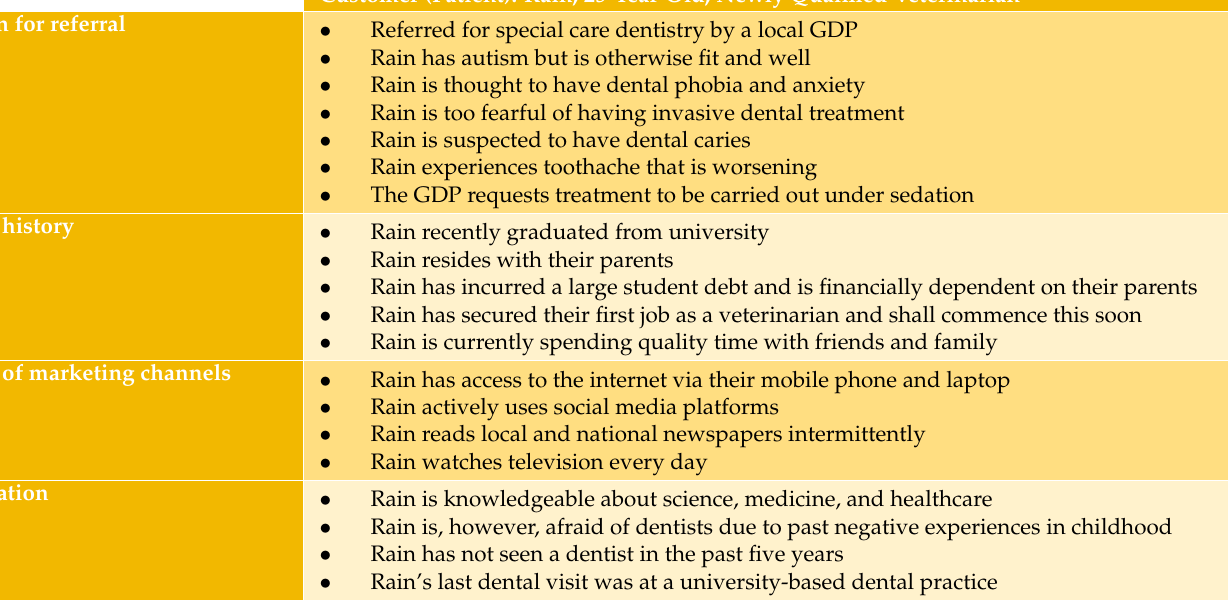
Table 2. Customer persona—a dental patient with special